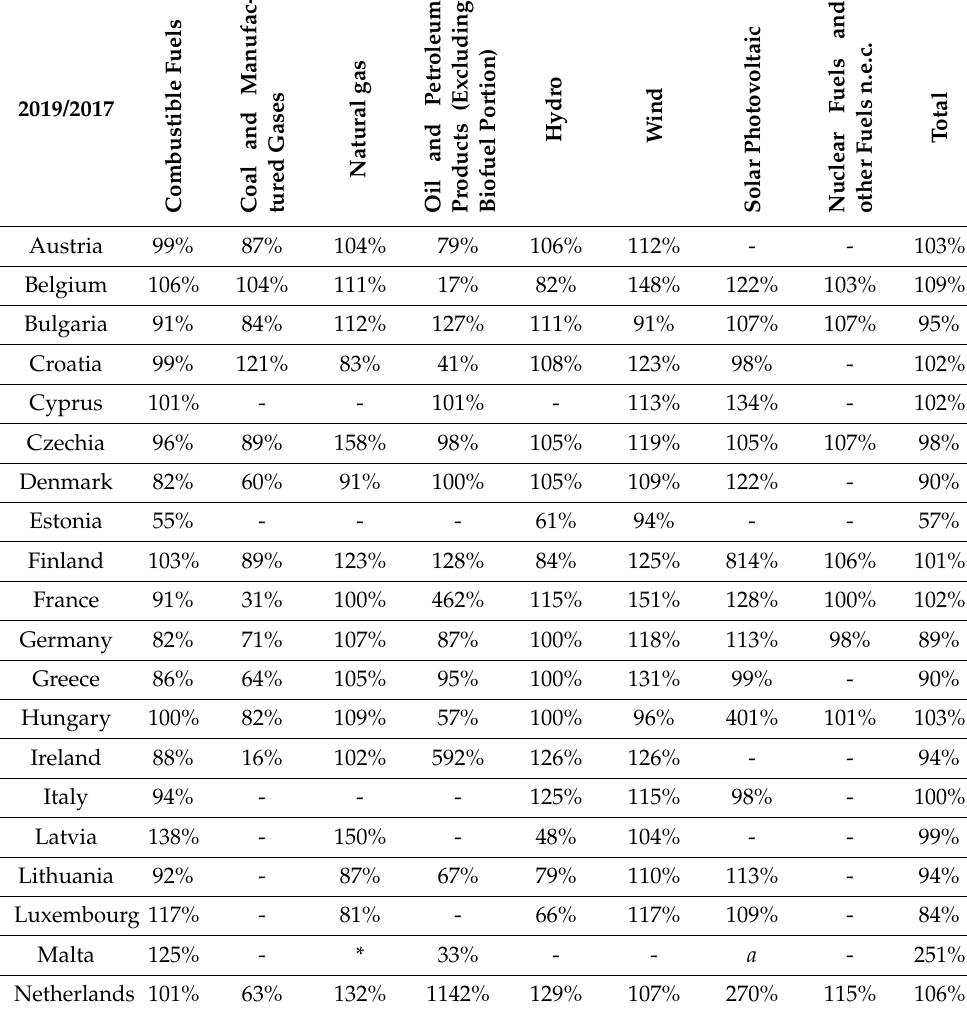
Table 1. Percentage change in net energy production in European Union (EU) countries in 2019 compared to 2017 by the division to the energy source